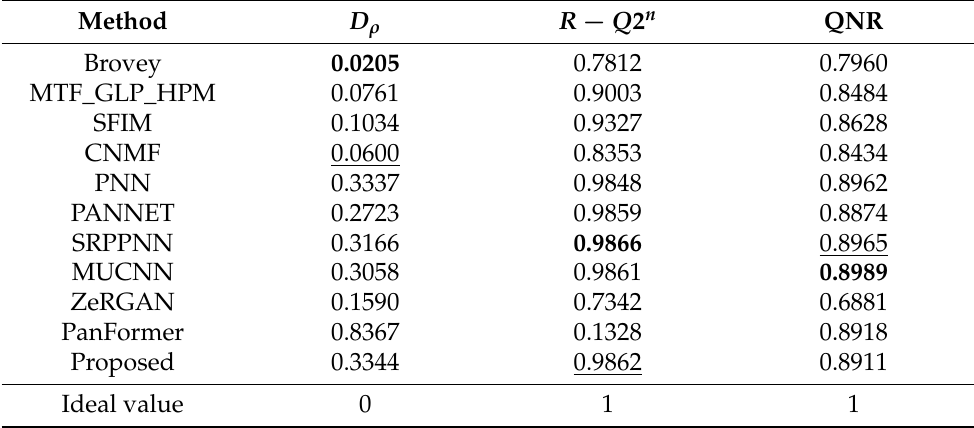
Table 2. Quantitative results of compared methods on the QB dataset in full resolution. The best values are shown in bold, and those in second place are underlined.